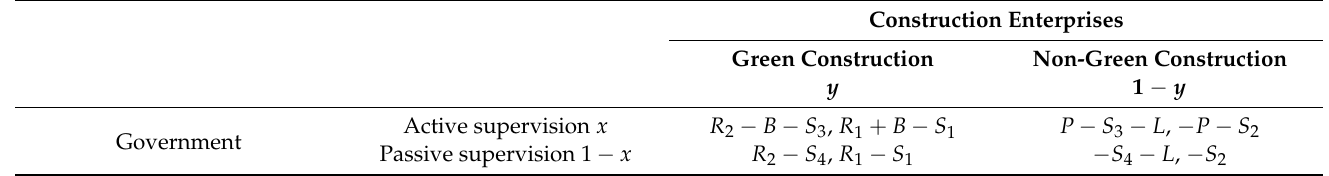
Table 2. The game payment matrix of government and construction enterprises under static reward and static